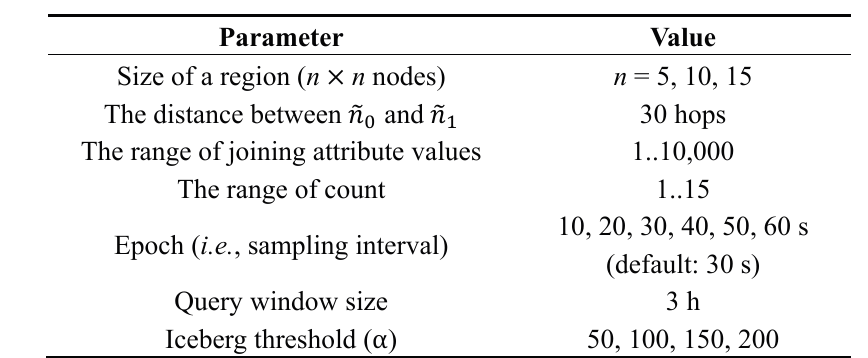
Table 2. Parameter Settings in the